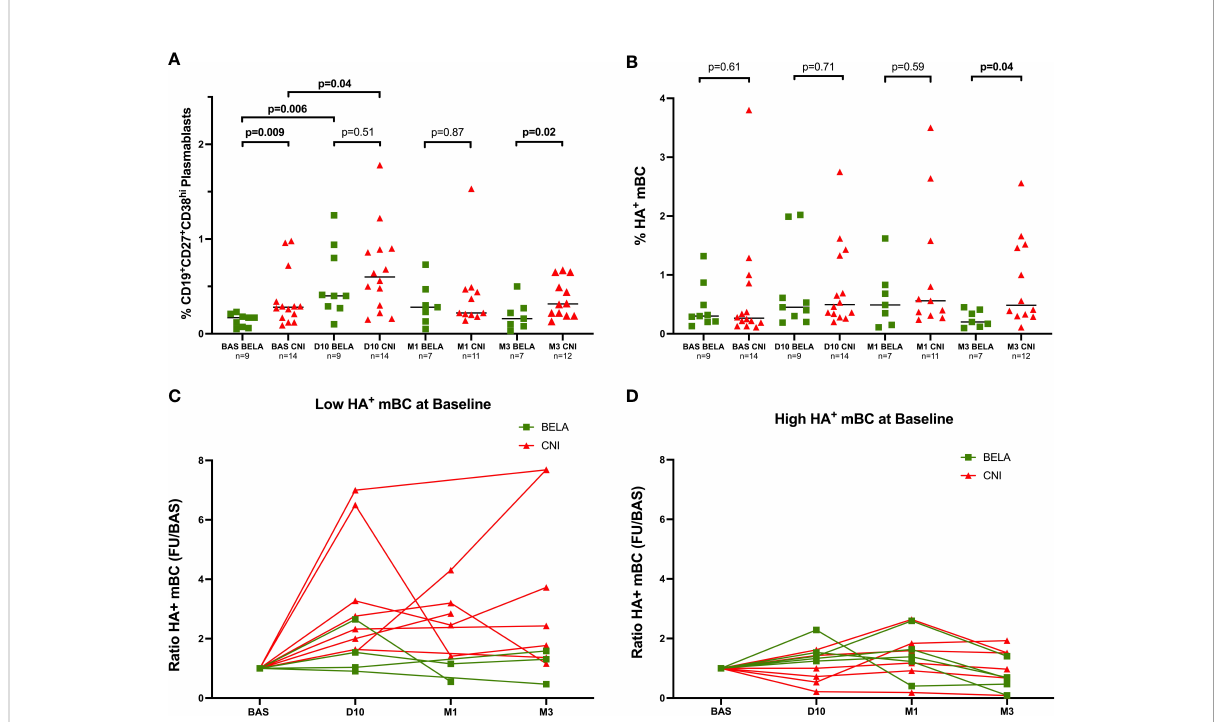
FIGURE 3 Kinetics of circulating Plasmablasts and In fl uenza-speci fi c B-cell subsets prior and after In fl uenza immunization. Figure 3A Proportion of CD19 + CD27 + CD38 hi plasmablasts. Figure 3B. Proportion of CD19 + CD27 + HA + mBc. Figure 3C. Analysis of HA + mBC expansion after immunization in patients with High preformed HA+mBc at baseline. Figure 3D. Analysis of HA + mBC expansion after immunization in patients with Low preformed HA+mBc at baseline. The proportions of CD19 + CD27 + CD38 hi cells (Figure 2A) and CD19 + CD27 + H1N1 + cells (Figure 2B) are expressed as a percentage in total lymphocytes in both Figures 3A, 3B. The ratio of H1N1 + CD19 + CD27 + mBC at D10, M1 and M3 after immunization (Figures 3C, 3D) = % H1N1 + CD19 + CD27 + mBC during follow-up/% H1N1 + CD19 + CD27 + mBC at baseline. Comparison of proportions between the two groups at each time point were analyzed using a Mann-Whitney